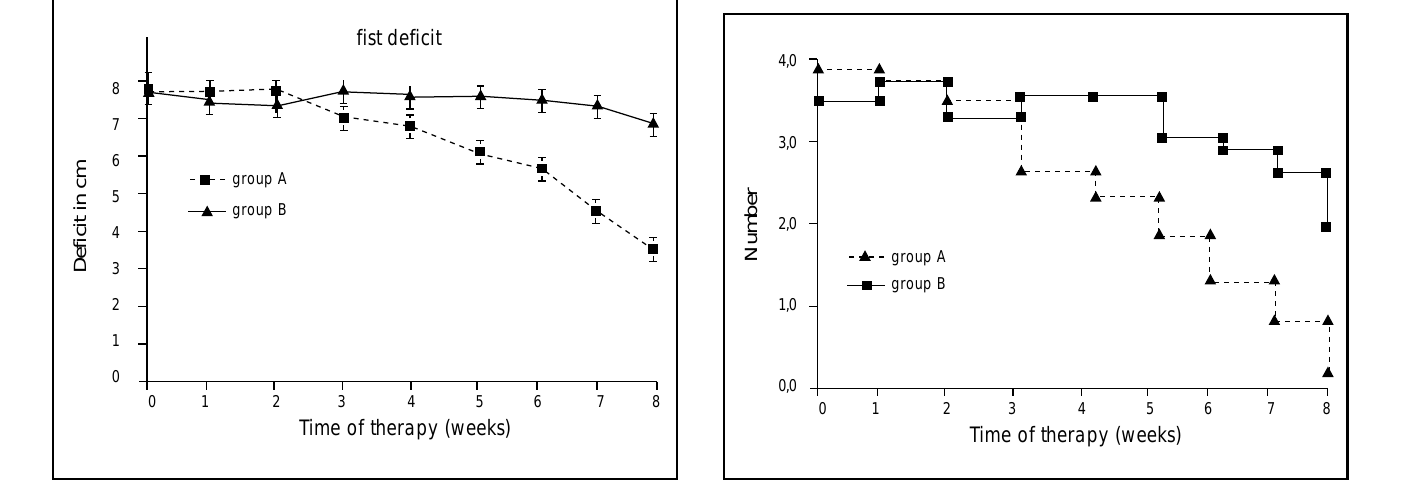
Figure 7: Number of patients with differences (>+0,8°C) between sides for the skin temperature of the hand in the course of 8 weeks.